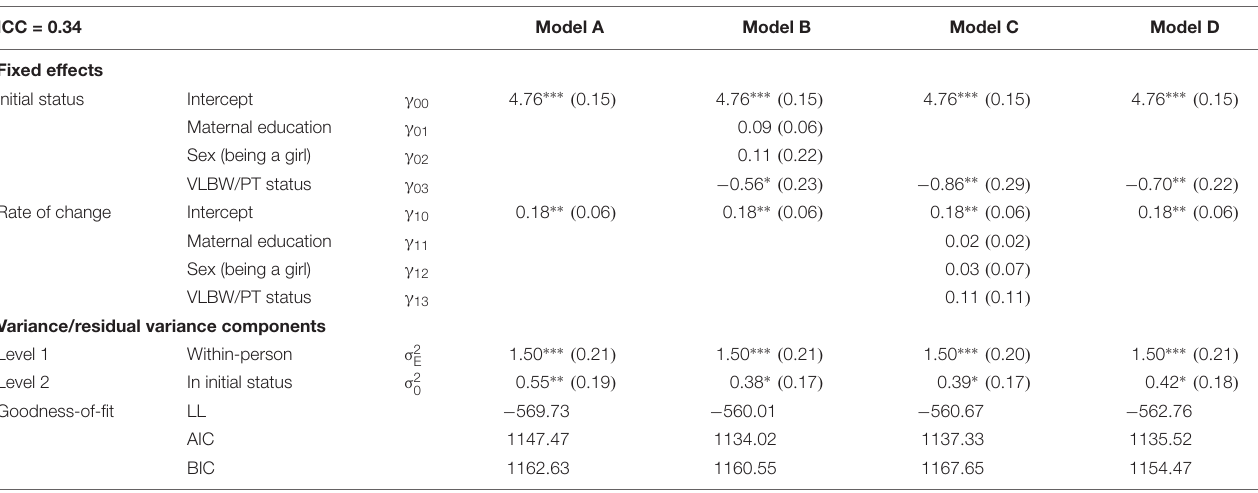
TABLE 6 | The growth models of child involvement between 6 and 57 months. ICC =